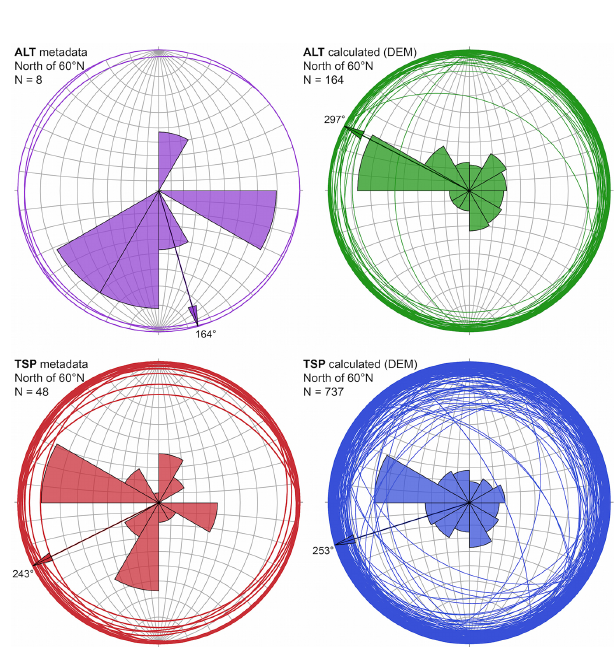
Figure 9. Terrains at TSP and ALT as spherical equal-angle pro- jections in stereonets and the frequencies of slope aspects as a rose diagram with bin size of 30 ◦ . Circle lines represent sutures of planes (site terrain) and their